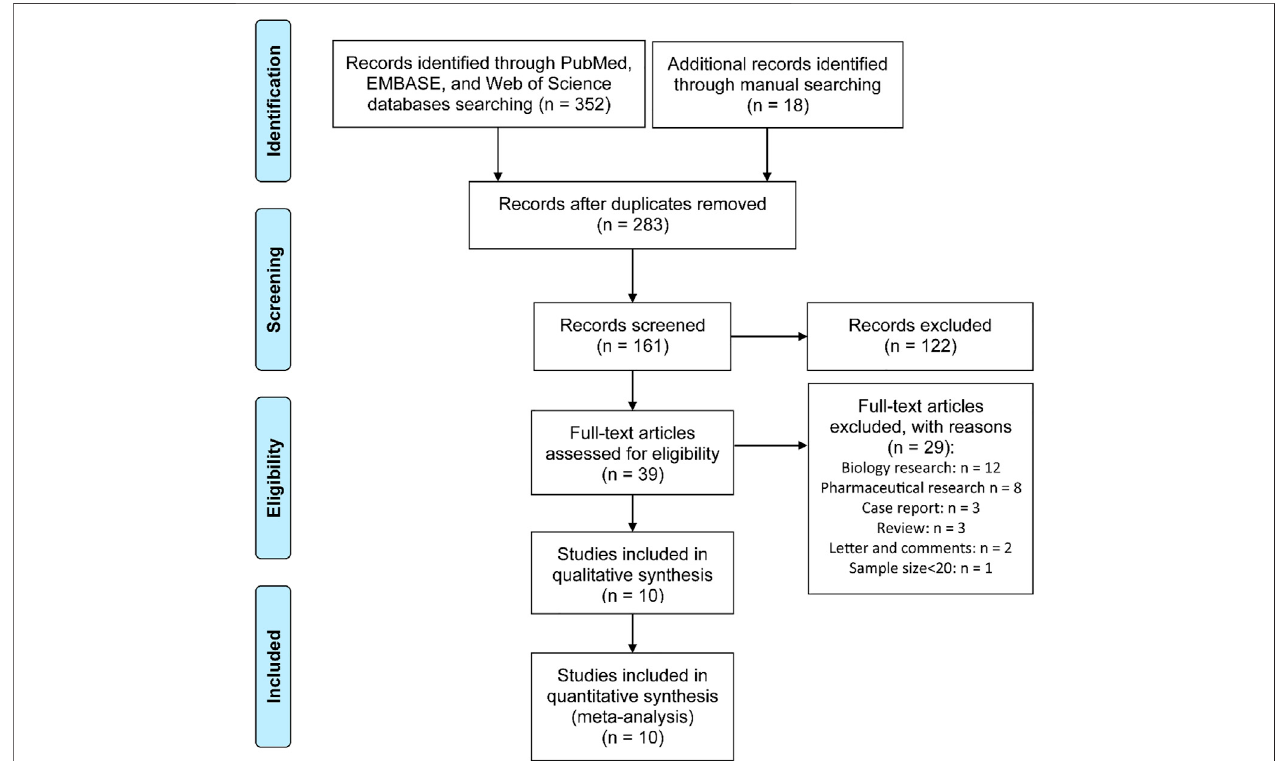
FIGURE 1 | PRISMA fl ow diagram for the process of study